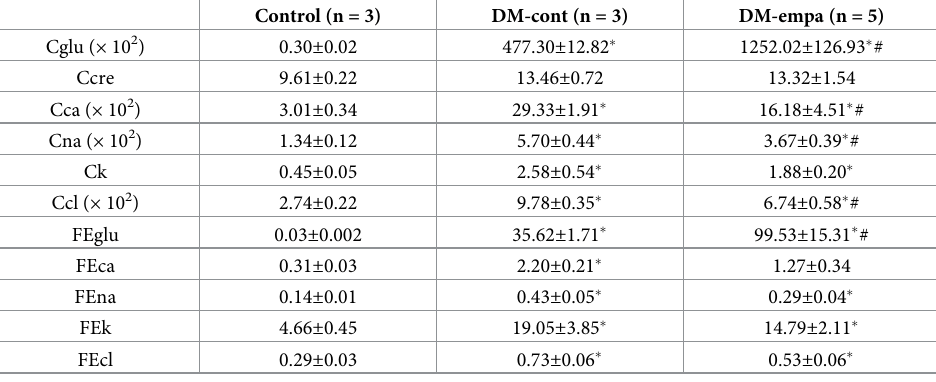
Clearance and fractional excretion of creatinine, sodium, and glucose after 12 weeks Data are represented as mean ± SE.